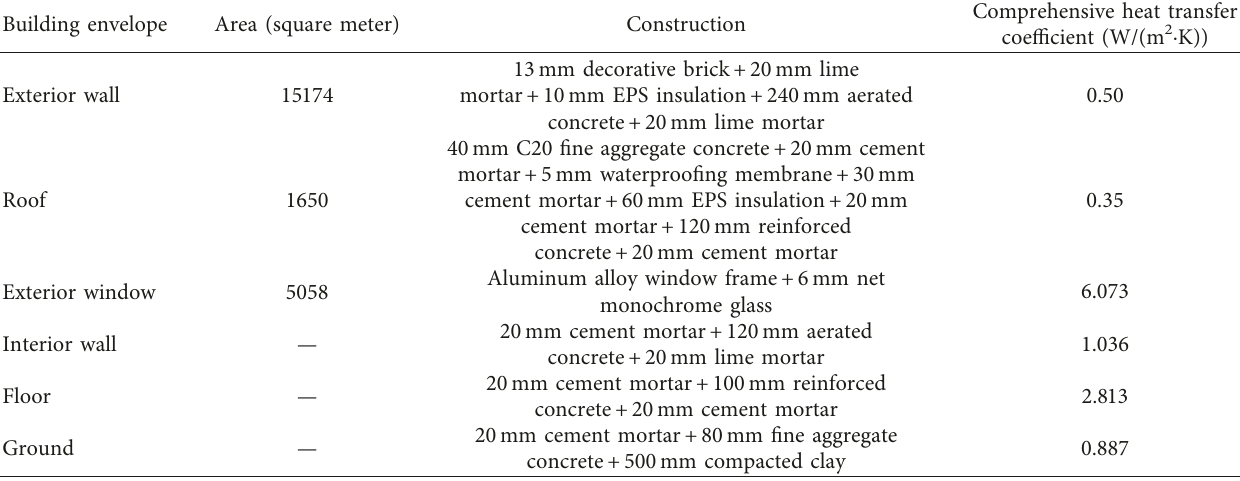
Table 1: Basic information and construction of the building envelope.